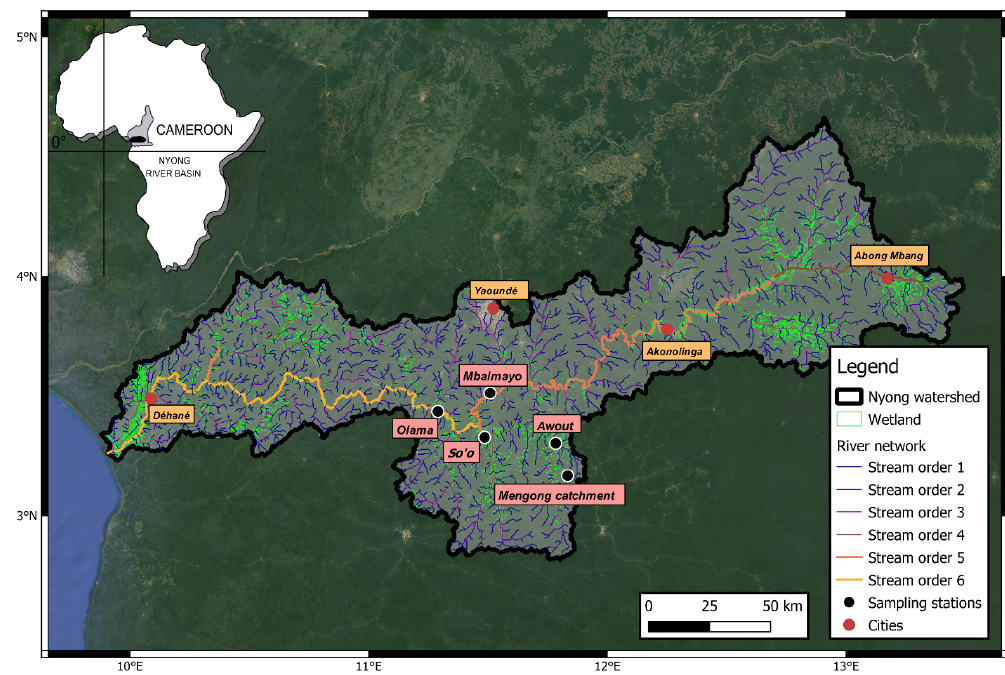
Figure 1. Map of the Nyong watershed showing the river network, the wetland extent from Gumbricht et al. (2017) and the location of the sampling stations and some cities. Note, the Nyong River is displayed bolder than the other rivers. The background map is from Google Satellite ®